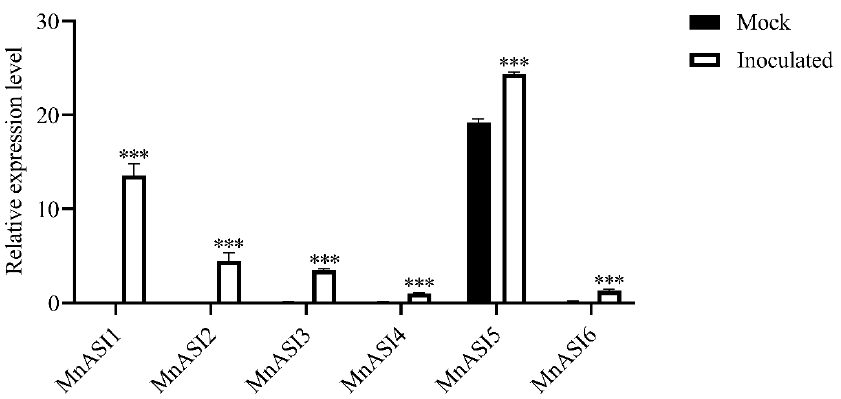
Figure 3. Relative expression levels of MnASIs in mock-treated (Mock) and B. cinerea inoculated (Inoculated) mulberry leaves. Error bars represent standard deviation, n = 3 (*** p -value < 0.001; two-tailed t -test).